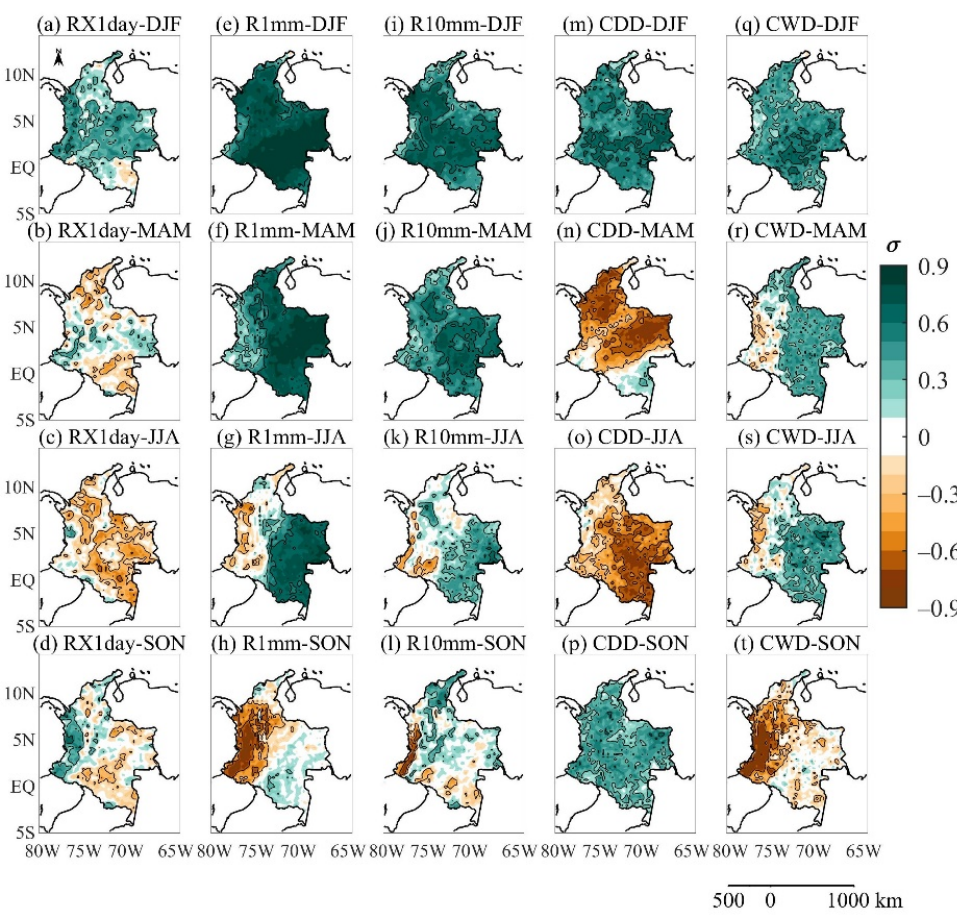
Figure A1. ( a – d ) Spatial pattern of Max 1-day precipitation amount (RX1day), ( e – h ) Number of wet days (R1mm), ( i – l ) Number of days with precipitations above R10mm (R10mm), ( m – p ) Consecutive dry days (CDD), and ( q – t ) Consecutive wet days (CWD) for the first TEOF mode during December–February (DJF) ( first row ), March–May (MAM) ( second row ), June–August (JJA) ( third row ), and September–November (SON) ( last row ).